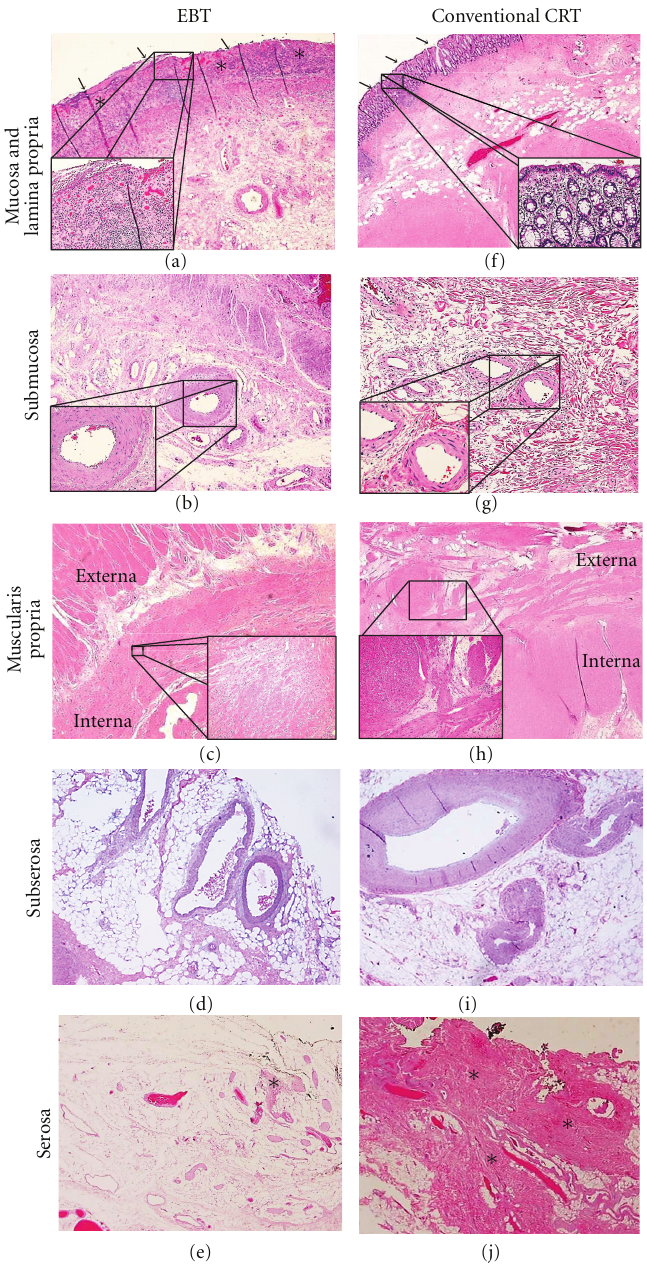
Figure 3: Representative H&E stained histopathologic sections at 4x magnification from patients who exhibited a complete pathologic response to EBT (a)–(e) and conventional external beam radiation (f)–(j). All images are taken from the region of the rectal wall where the tumor was located prior to neoadjuvant therapy. All insets are shown at 20x magnification. First row: at the mucosa, extensive ulceration (solid arrows) is apparent after EBT (a), while the mucosa remains intact (solid arrows) after conventional CRT (f). Hyalinization of the lamina propria (asterisks) is also evident after EBT (a). Second row: in the submucosa, marked hypertrophy and sclerosis of vessel walls can be seen following EBT (b), while only slight hypertrophy of vessel walls is seen after conventional CRT (g). Third row: within the muscularis propria, the more superficial interna layer can be seen to exhibit degeneration and atrophy after EBT while the externa layer remains largely intact (c); in a contrary fashion, following conventional CRT, it is the externa layer that exhibits more prominent degeneration compared to the interna (h). fourth row: at the level of the subserosa, vessel walls appear normal in patients treated with EBT (d), but distinctly hypertrophied in patients treated with conventional CRT (i). Fifth row: the serosa demonstrates few adhesions (asterisk) after treatment with EBT (e), in contrast to the extensive adhesions (asterisks) present after treatment with conventional CRT